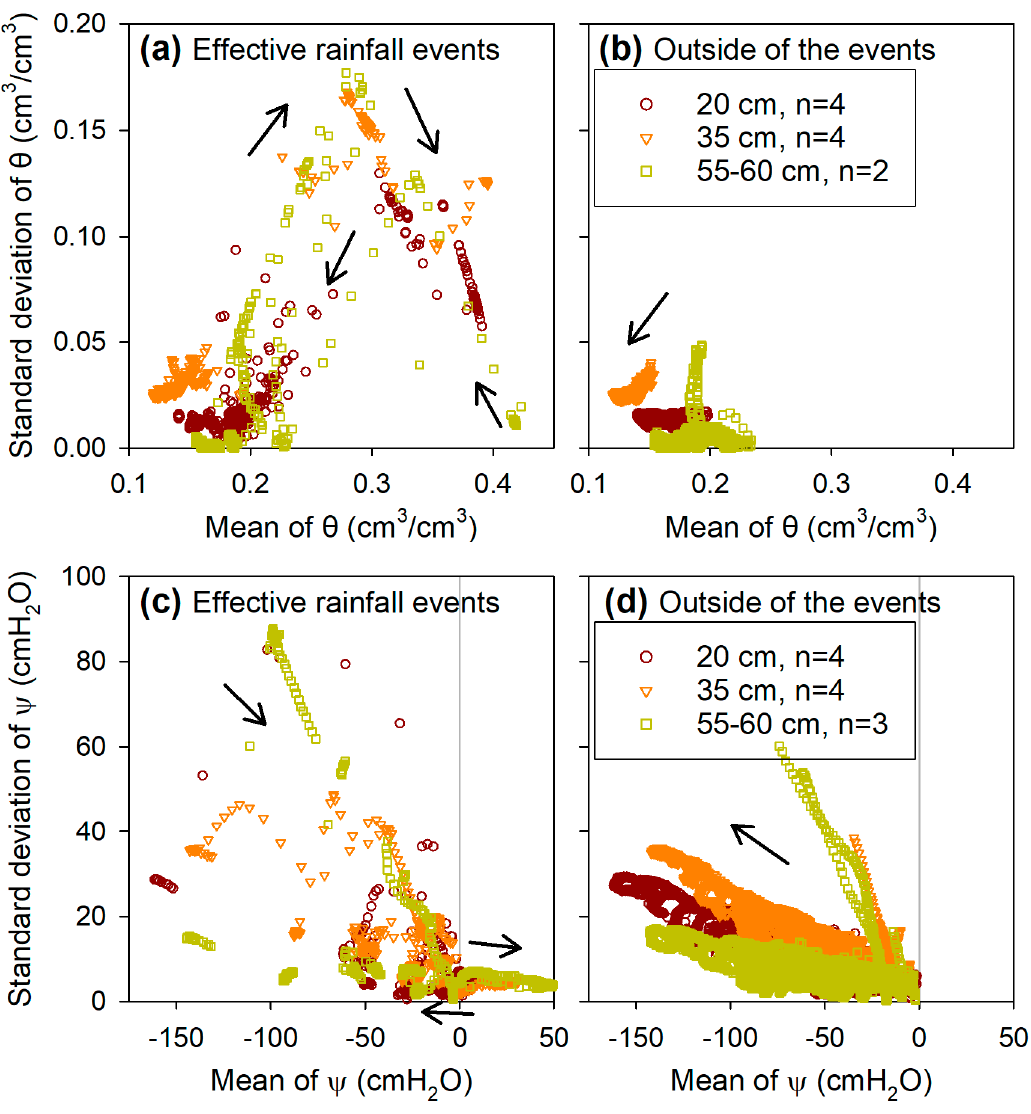
Figure 4. Relationships between the mean and standard deviation (denoted “µ- σ “) of soil water content ( θ ) during ( a ) the effective rainfall events and ( b ) outside of the events, and the µ- σ of soil water potential ( ψ ) during ( c ) the effective rainfall events and ( d ) outside of the events. The n indicates the sample size of soil water content or soil water potential used for deriving the µ- σ at each depth. Arrows indicate transition dynamics.